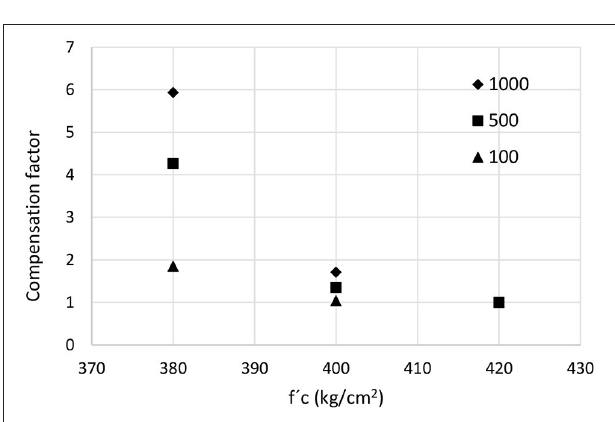
FIGURE 12 | Compensation factors for several actual values of f ′ c, several losses levels, H = 8m and nominal f ′ c = 420 Kg/cm 2 , Acapulco.